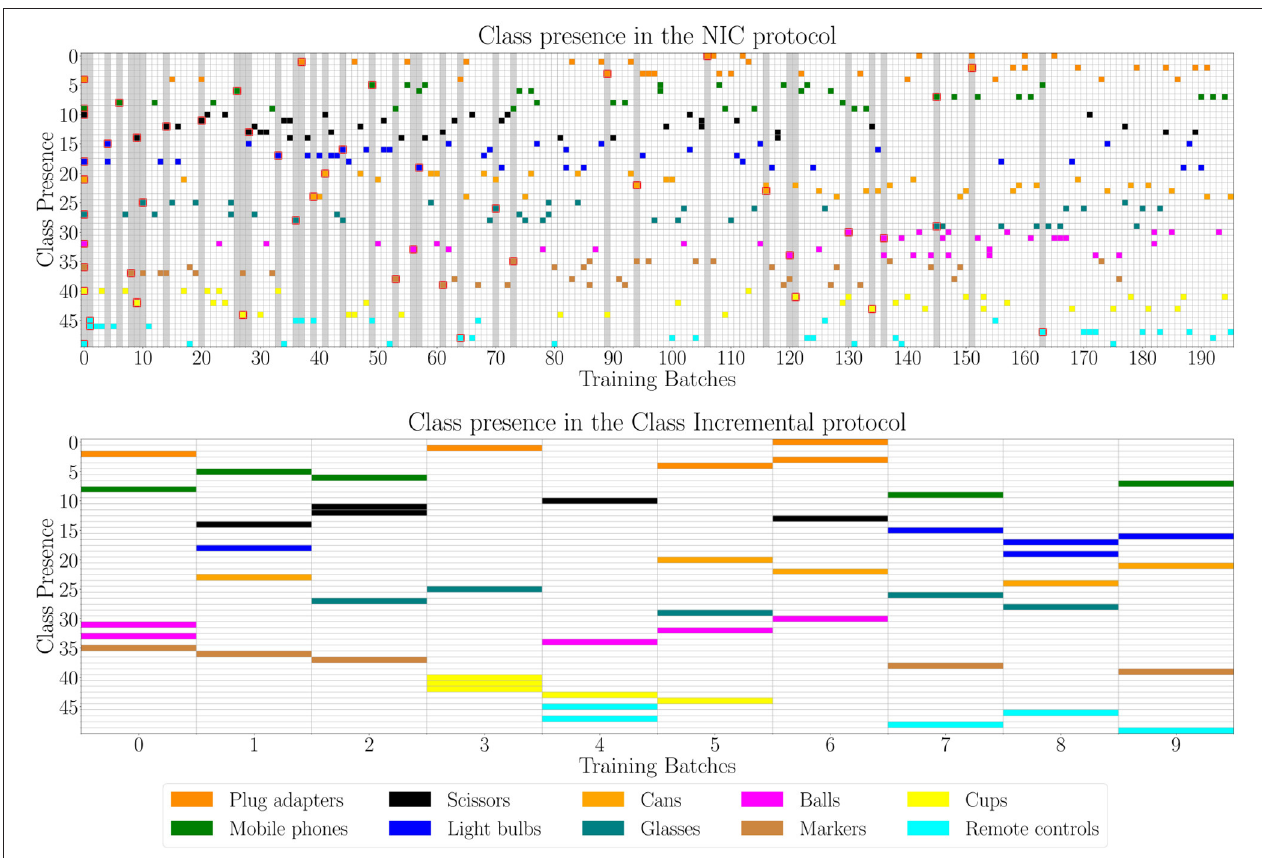
FIGURE 1 | Comparison between class presence in continual learning streams from the NIC scenario (above) and class-incremental scenario (below). Each row represents a different class, while colors group classes into macro-categories (taken from CORe50 benchmark; Lomonaco and Maltoni, 2017). The horizontal axis represents experiences (training batches). Gray vertical lines in the NIC scenario indicate the introduction of at least a new class in that experience (the newly introduced classes are surrounded by a red square). The NIC protocol shows a longer stream than class-incremental, with a more diverse distribution of the classes.